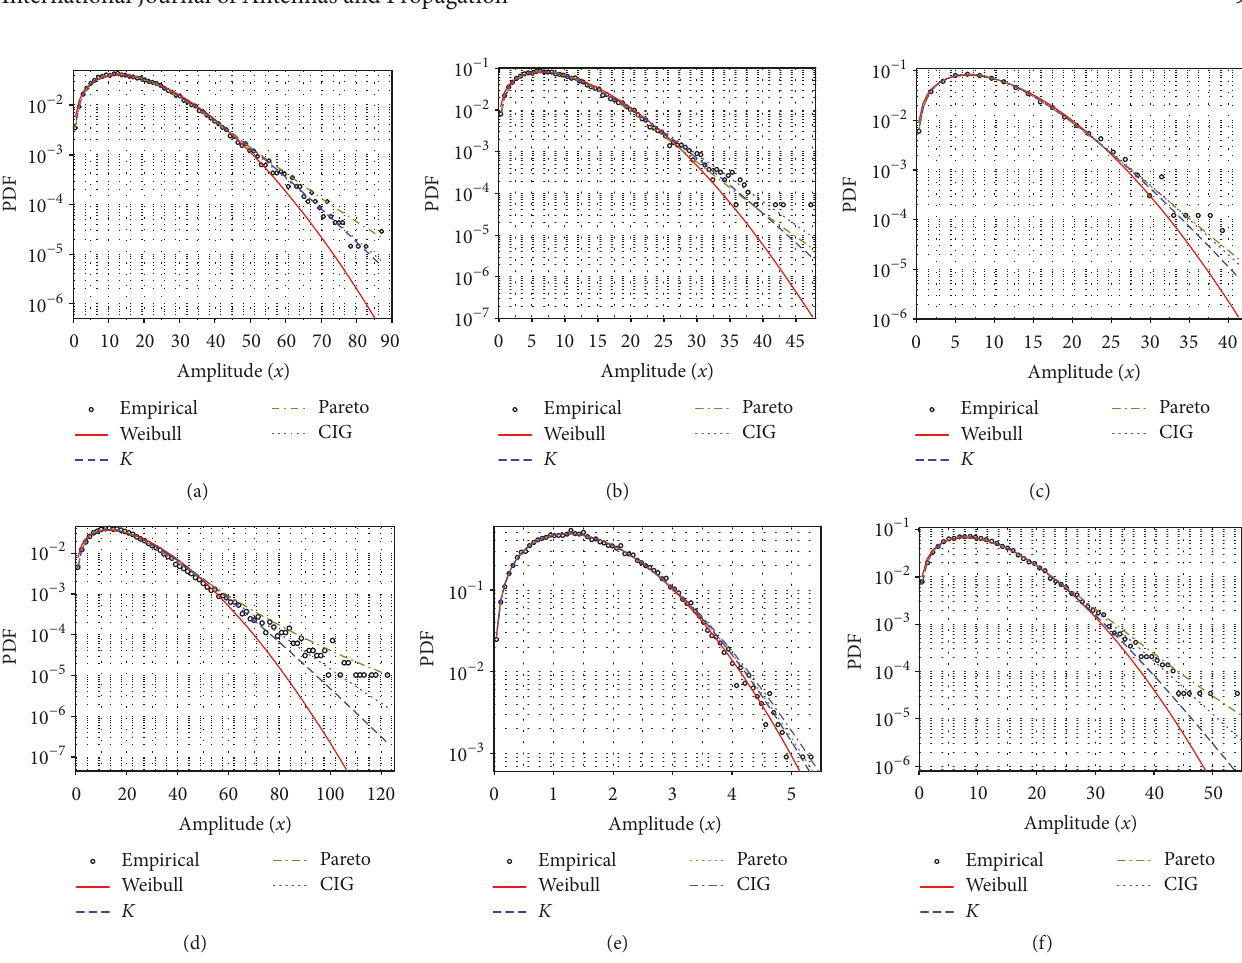
reasonable 𝐾 distribution parameters before modeling 𝐾 distribution monopulse radar